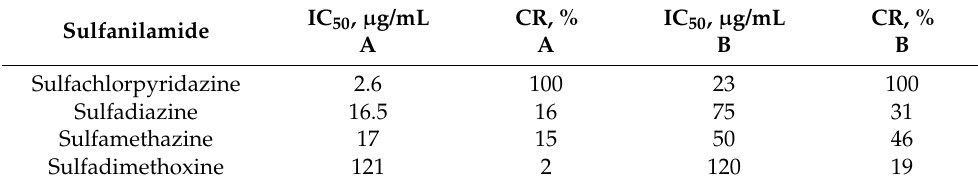
Table 3. Determination of IC 50 values of FPIA calibration curves and cross ‐ reactivity of sulfona ‐ mides at various concentrations of antibodies and labeled hapten. A—the concentration of SA ‐ (flu ‐ orescein derivative) conjugate = 0.16 nM, the concentration of specific antibodies = 0.2 nM. B—the concentration of SA ‐ (fluorescein derivative) conjugate = 0.8 nM, the concentration of specific anti ‐ bodies = 1 nM.